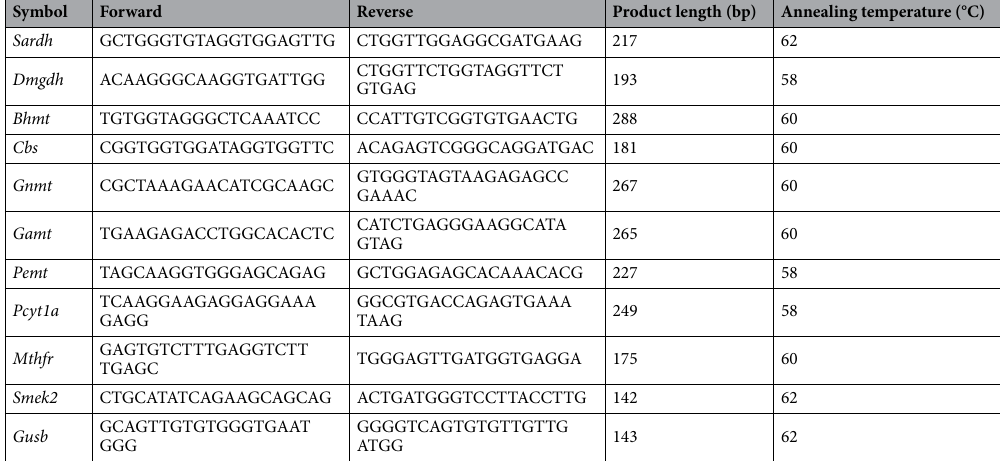
Table 6. Primers for real-time RT-PCR. Bhmt , betaine-homocysteine methyltransferase; Cbs , cystathionine beta-synthase; Dmgdh , dimethylglycine dehydrogenase; Gamt , guanidinoacetate methyltransferase; Gnmt , glycine N-methyltransferase; Gusb , glucuronidase; beta; Ms , methionine synthase; Mthfr , methylenetetrahydrofolate reductase; Pcyt , phosphate cytidylyltransferase; Pemt ; phosphatidylethanolamine N-methyltransferase; Sardh ; sarcosine dehydrogenase; Smek , suppressor of MEK.